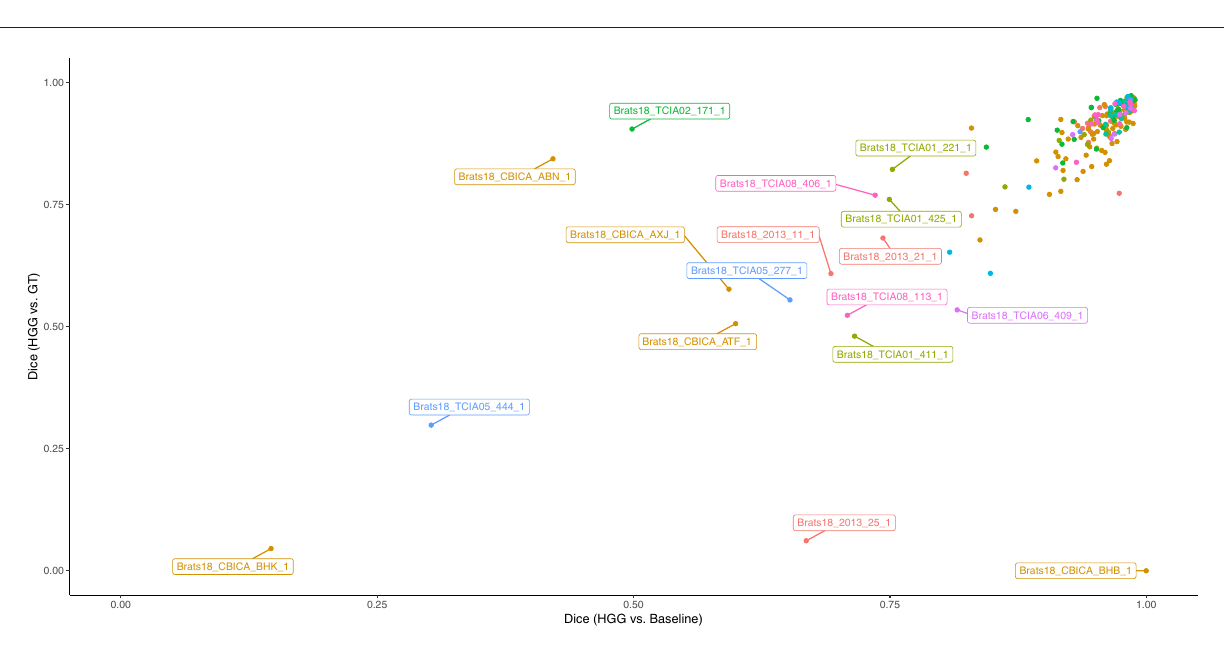
FIGURE 3 | Performance of the HGG-only model for the tumor core (y-axis) and agreement with the baseline model (x-axis). Subjects with a label were visually reviewed. Colors indicate the center (2013, CBICA, TCIA01-08).